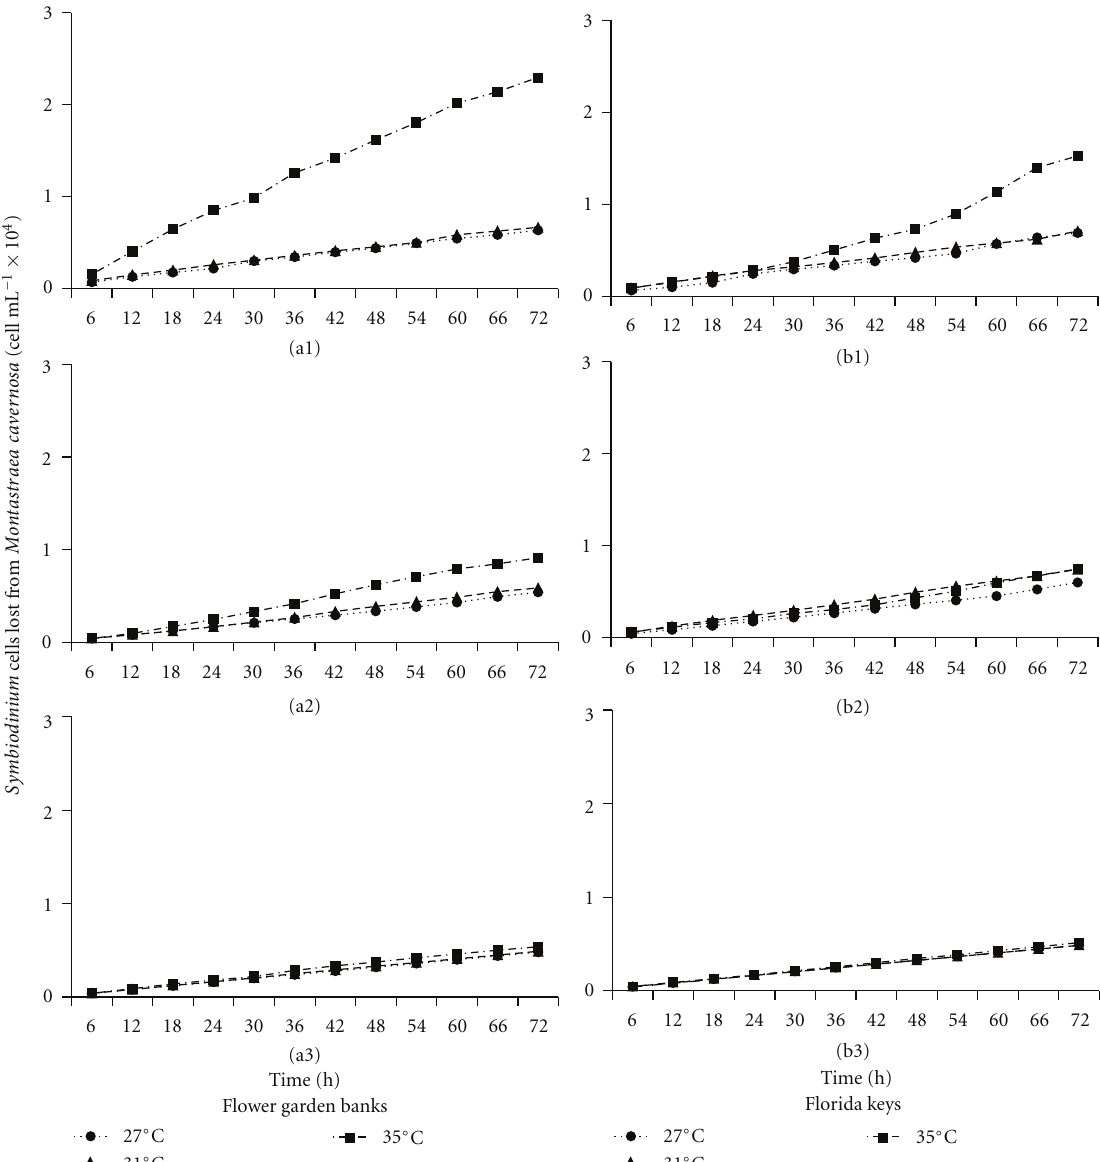
Figure 4: Hemocytometry data showing the mean cumulative loss of viable (a1, b1), necrotic (a2, b2), and mitotic (a3, b3) zooxanthellae cells ( × 10 3 mL − 1 ) expelled from Montastraea cavernosa collected from the Flower Garden Banks National Marine Sanctuary (a1–3)) and the Florida Keys National Marine Sanctuary (b1–3)) sampled every 6h over a 72h time period at 27 ◦ C ( represent 95% confidence intervals ( n i = 8); some error bars are too small to be seen. Note how cumulative graphs illustrate the e ff ect of temperature on overall depletion of a coral’s Symbiodinium complement over 72